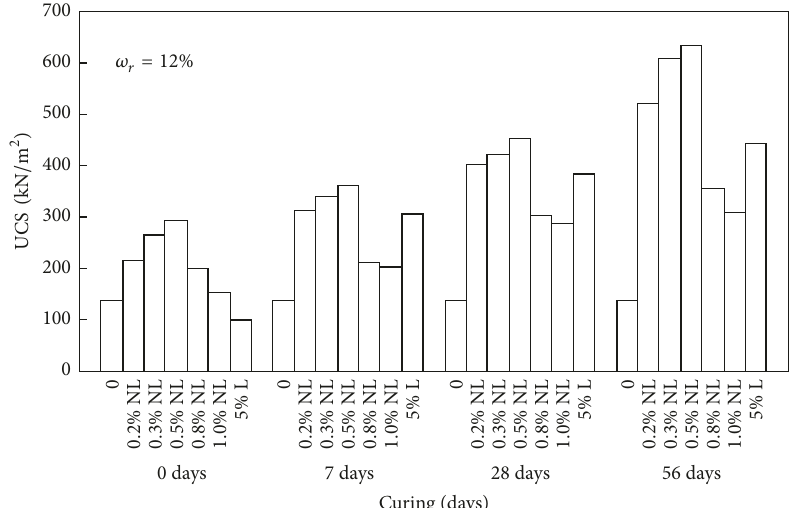
Figure 3: UCS development over curing periods for original soil, soil-nanolime mixtures, and soil-lime mixture at remolded water content of